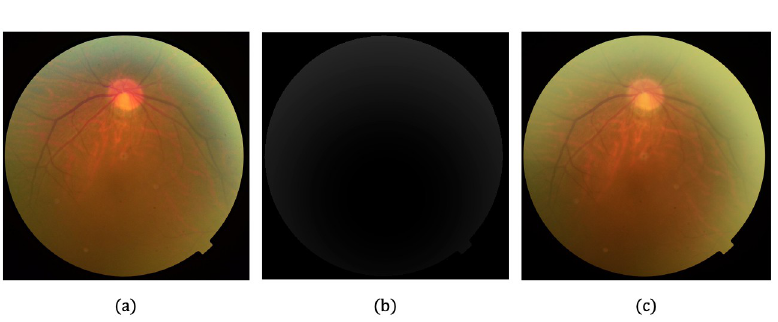
Fig 2. Synthesizing hazy image. (a) Original HQ image. (b) Manually crafted depth map. (c) Created hazy image.